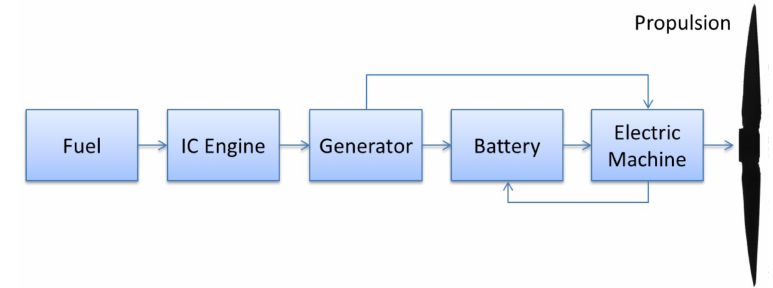
Figure 5. A possible series configuration energy flow chart. IC: internal